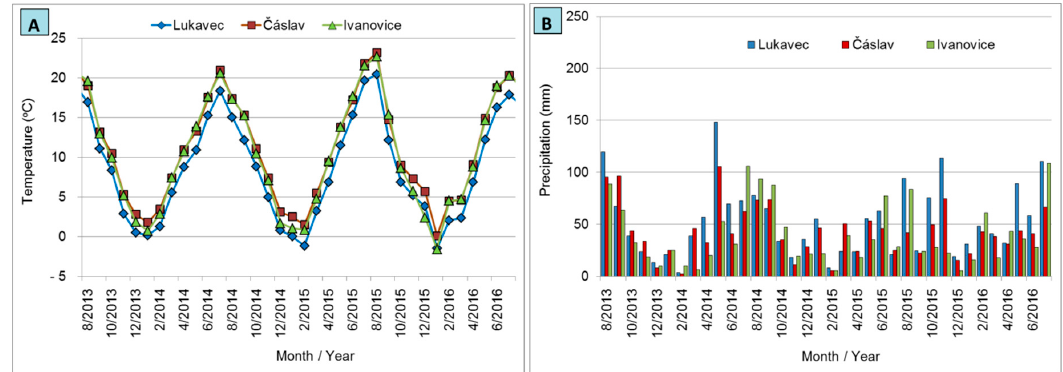
Table 1. Average inputs of N, P, and K in the mineral and organic fertilizers into the wheat and within the whole crop rotation.